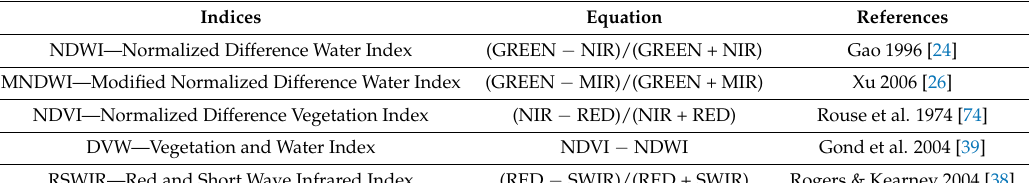
Table 2. List of multispectral indices derived from the spectral bands of Landsat-7 image data.